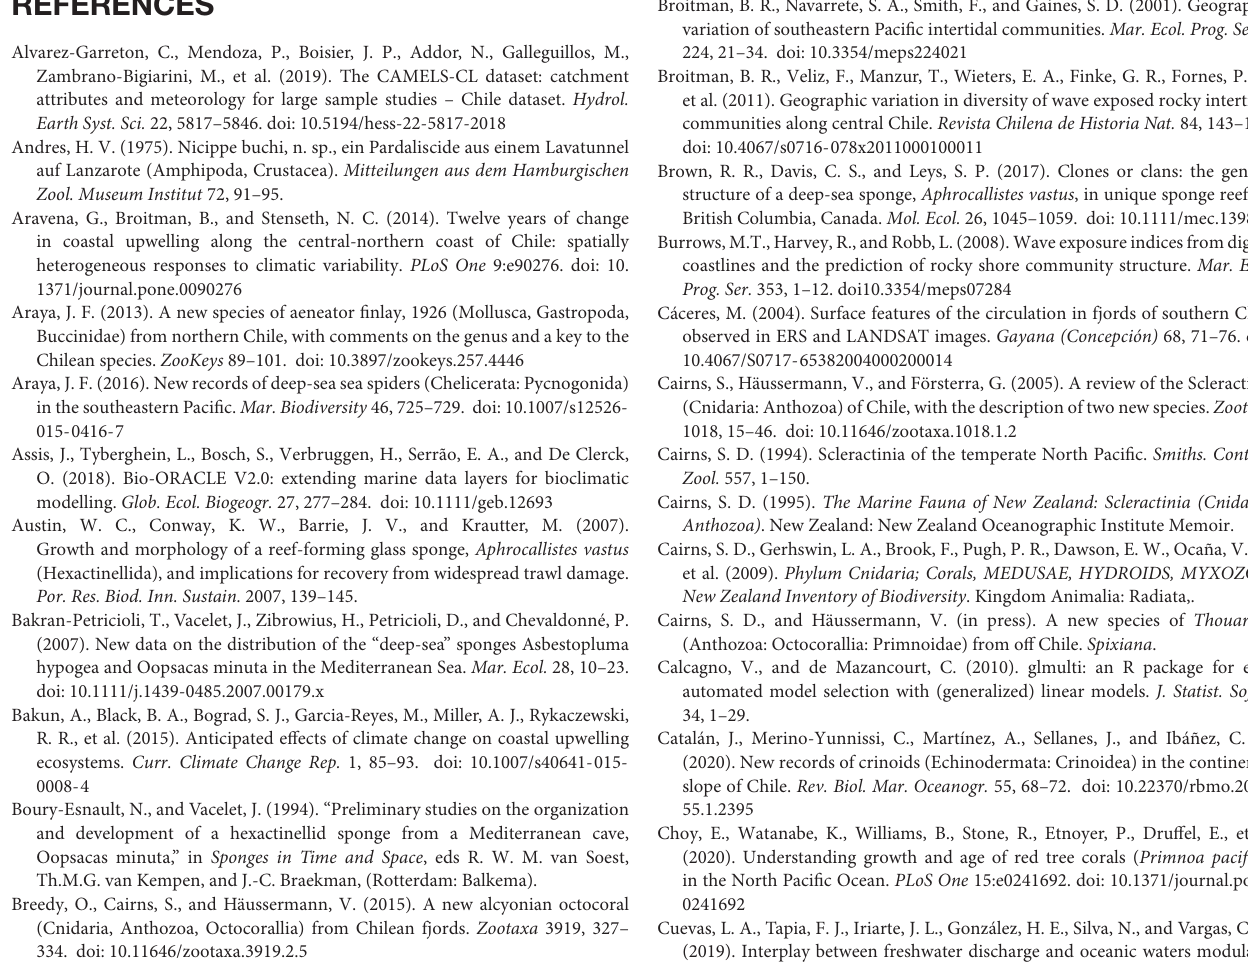
from NASA MODIS Aqua and Terra Satellites. Darker areas indicate a higher incidence of Kd_490 and thus a smaller attenuation depth and lower clarity of ocean water (Zhong-Ping et al., 2005). Supplementary Figure 10 | Wave Exposure Model for Chilean Patagonia, showing areas of high (red) to low (blue) energy wave action. Wave exposure is a derived product of wave fetch and wave energy, that calculates the wind energy as a function of wind speed average occurrence and direction, and wave fetch as a derivative of distance and direction of energy to the coastline, with the maximum wave fetch set at 200 km. Model produced by M. T. Burrows, Department of Ecology, Scottish Association for Marine Science (Burrows et al., 2008). Supplementary Figure 11 | Presence of macroalgae based on Huinay Fiordos Expeditions. Abundances of macroalgae strongly rise with elevated surface salinity values which, in Patagonia, can be found along the exposed coast and in some channels, but usually not inside fjords (for model, see Supplementary Table 1 | Presence points of the 28 species and six genera used during the present study: number of presence points in: North and Central Chile Supplementary Table 2 | Relationship of the occurrence probability with depth, site and genus. SE, standard error; z, Z-statistics; P, p